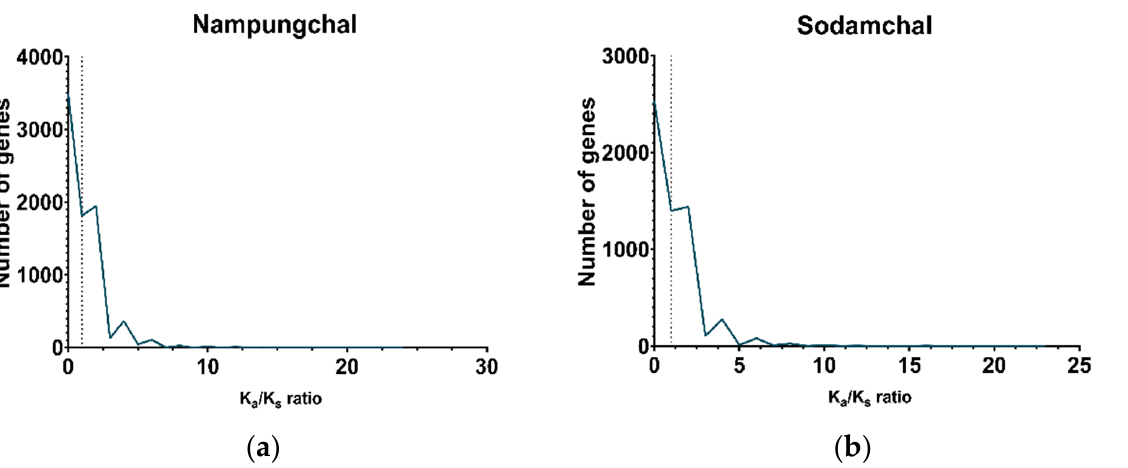
Figure 9. Distribution of the K a /K s ratio of the genotype genes of the two sorghum cultivars: ( a ) Nampungchal and ( b ) Sodamchal. The y -axis represents the number of genes, and the x -axis represents the K a /K s ratio of the genes. The dotted line represents a K a /K s ratio of 1 which determines the selective pressure.